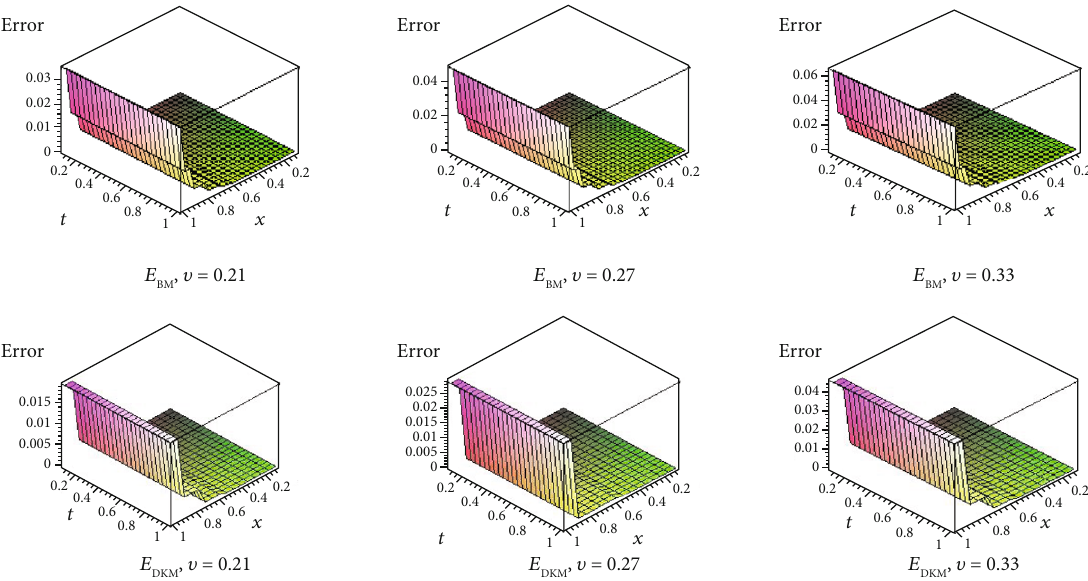
Figure 9: The values of errors by B-by-BM and DKM at T = 1 , N = 10 , and k = 2 for υ = 0 : 21, 0 : 27, 0 : 33 .